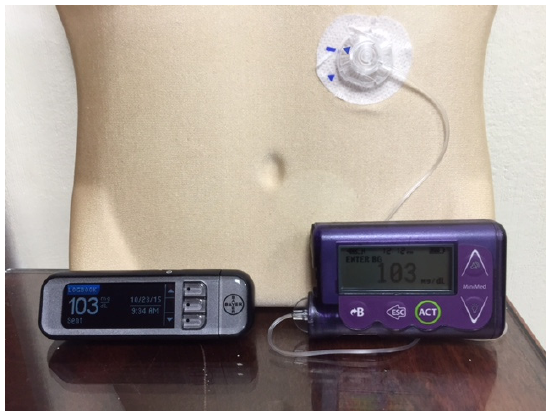
Figure 1. A Medtronic Minimed Insulin Pump and a blood glucose meter that communicates blood glucose readings wirelessly with it.